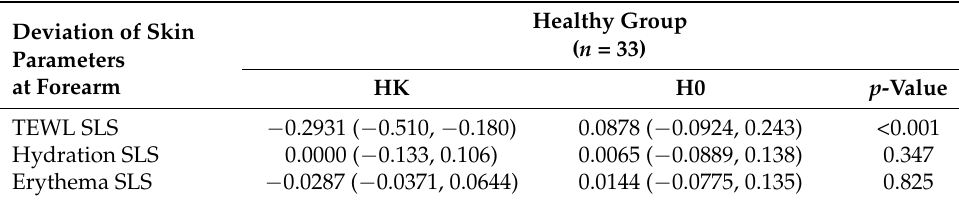
Table 4. Variation of skin parameters, after lesion induction with SLS, for the healthy group (median (Q1, Q3)).